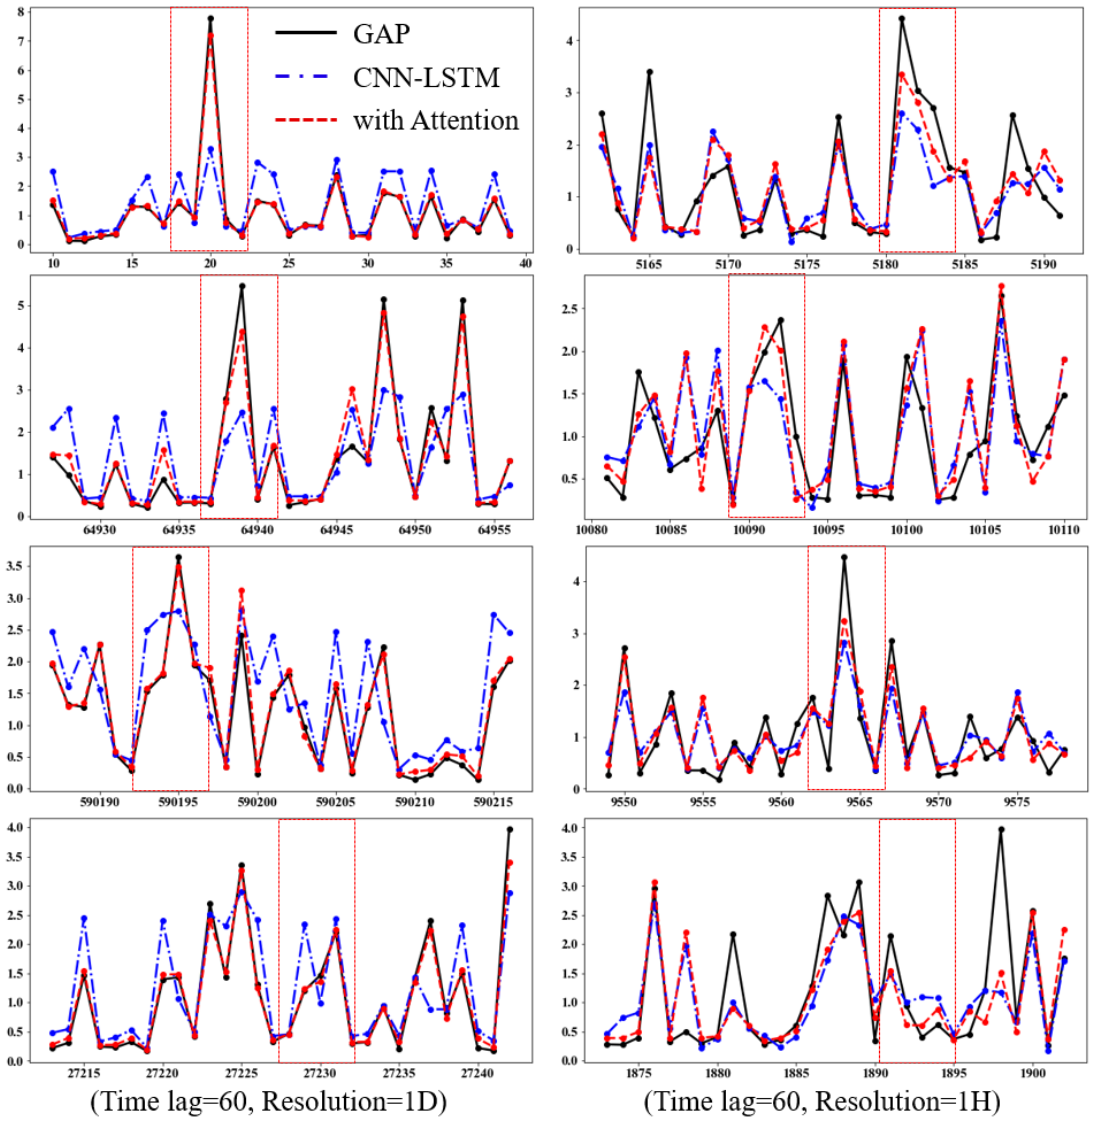
Figure 8. Verification of robustness to transient, impulsive characteristics of power consumption data.